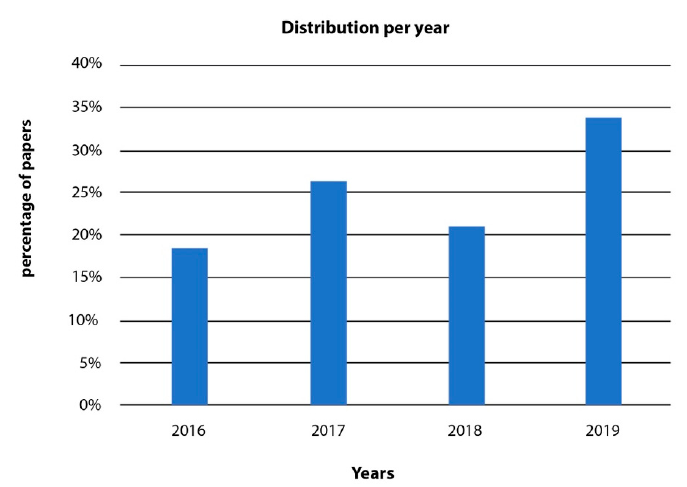
Figure 1. The image shows the distribution of the papers in the last few years. Energies 2020 , 13 , x FOR PEER REVIEW